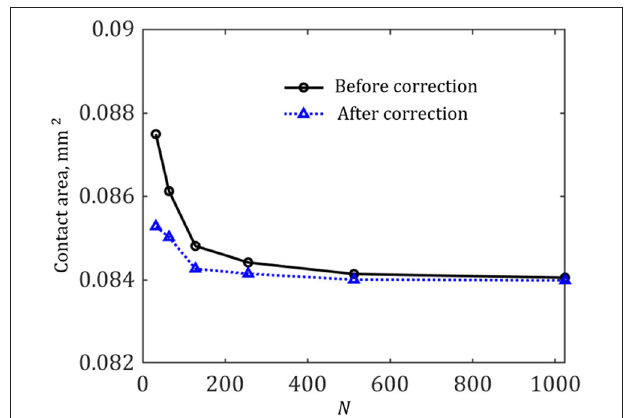
FIGURE 3 | The contact area for δ = 0.05mm with and without correction as a function of element